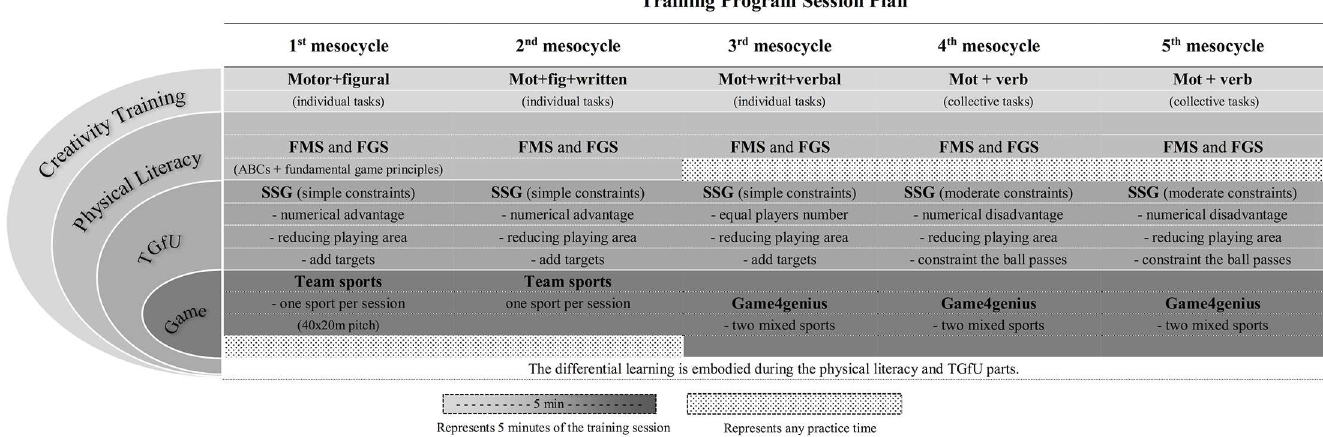
Fig 1. Creativitytraining program schedule during different mesocycles. Legend:mot., motor; fig.; figural: writ., written; verb., verbal; FMS, fundamental movement skills; FGS, fundamental game skills; ABCs, agility, balance, coordination and speed; TGfU, teaching games for understanding; SSG, small-sided games. A mesocyclecorresponds to a month of trainingwhich includes12 practical sessions with 60 minutes each.